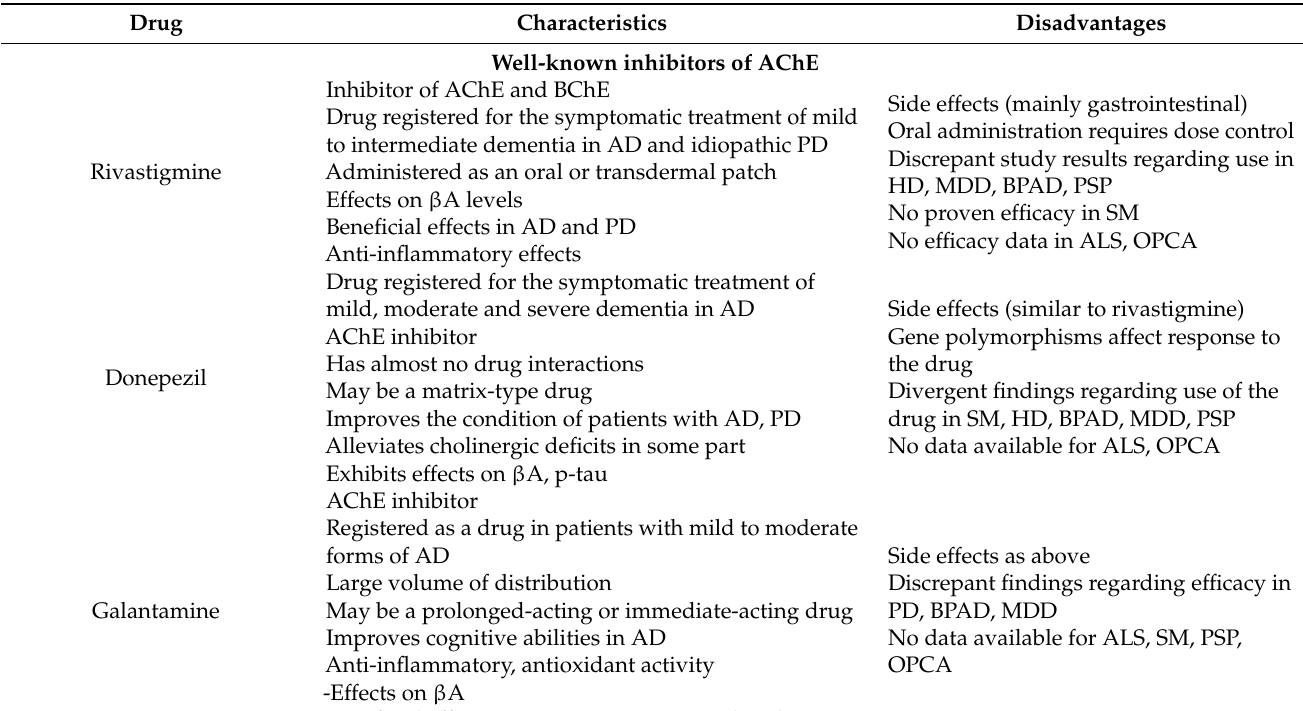
Table 1. Characteristics of the mentioned